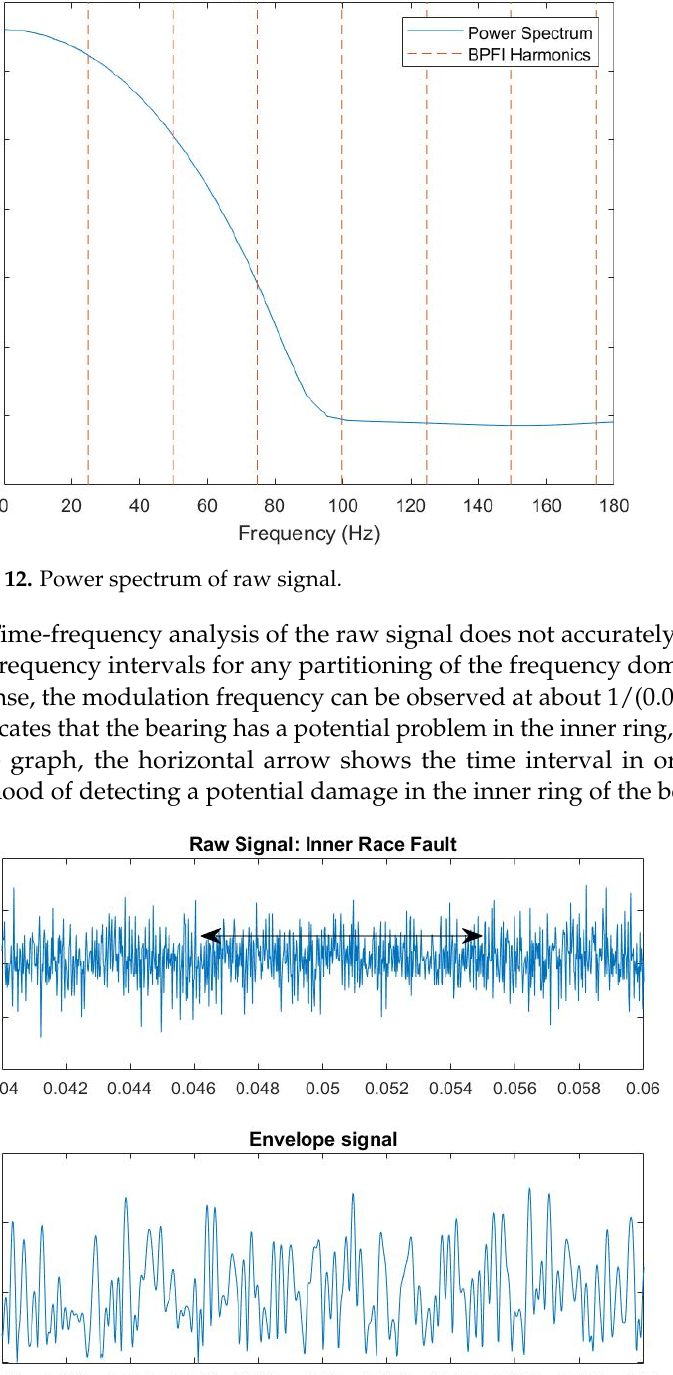
Figure 11. Raw signal of the damaged inner ring in frequency domain.